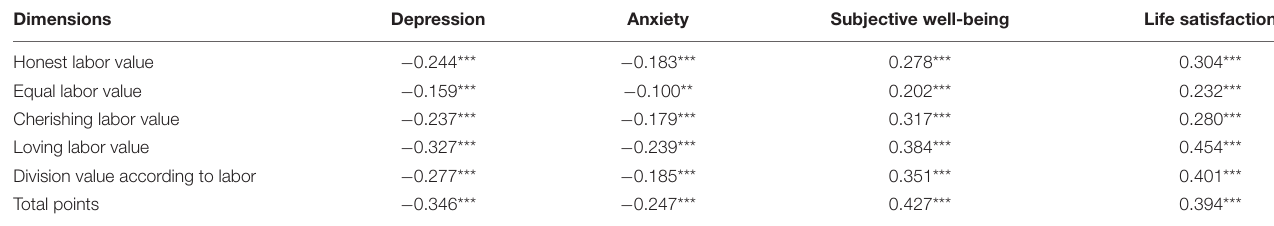
TABLE 3 | Each dimension is related to positive and negative emotions and